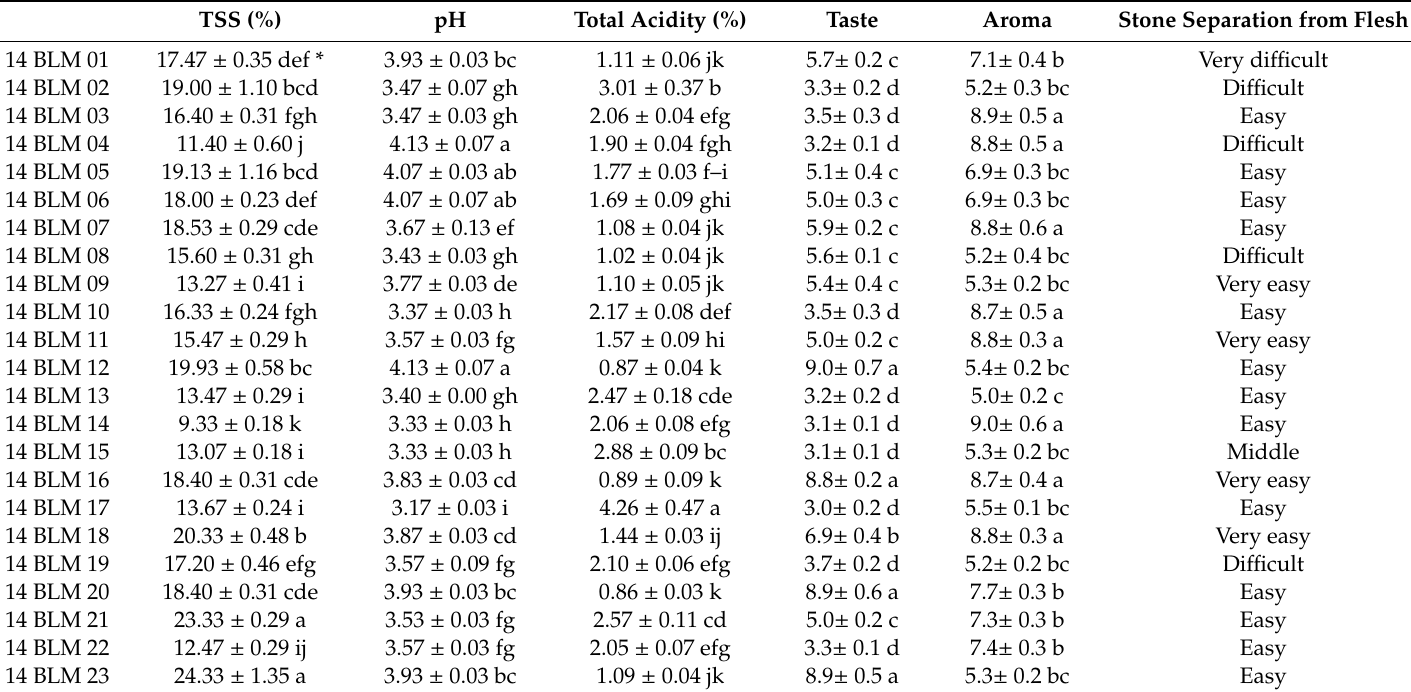
* : Di ff erent letters in columns indicate significantly di ff erent values at p ≤